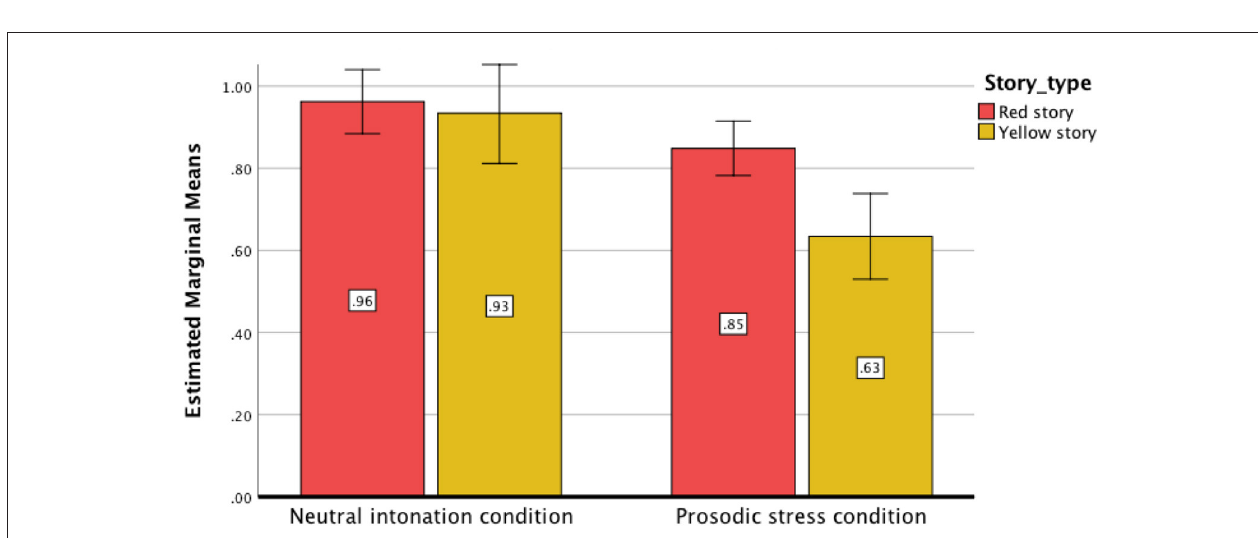
FIGURE 4 | Proportions of disjunction narrow scope reading responses: Neutral Intonation and Prosodic Stress conditions